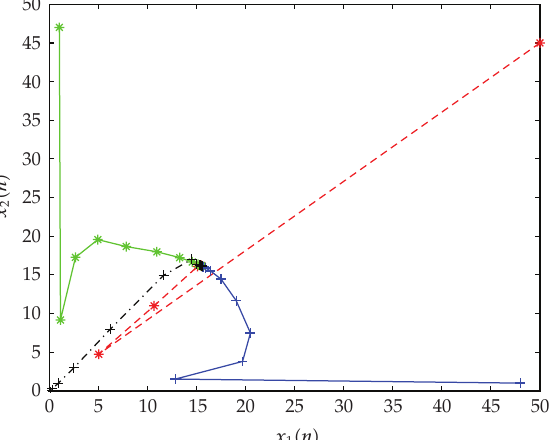
Figure 2: Solutions of system (cid:3) 1.1 (cid:4) with initial values (cid:3) x 1 (cid:3) 0 (cid:4) ,x 2 (cid:3) 0 (cid:4)(cid:4) (cid:5) (cid:3) 50 , 45 (cid:4) , (cid:3) 1 , 47 (cid:4) , (cid:3) 0 . 1 , 0 . 09 (cid:4) , (cid:3) 48 , 0 . 1 (cid:4) , and r 1 (cid:5) 1 . 1 ,r 2 (cid:5) 1 .